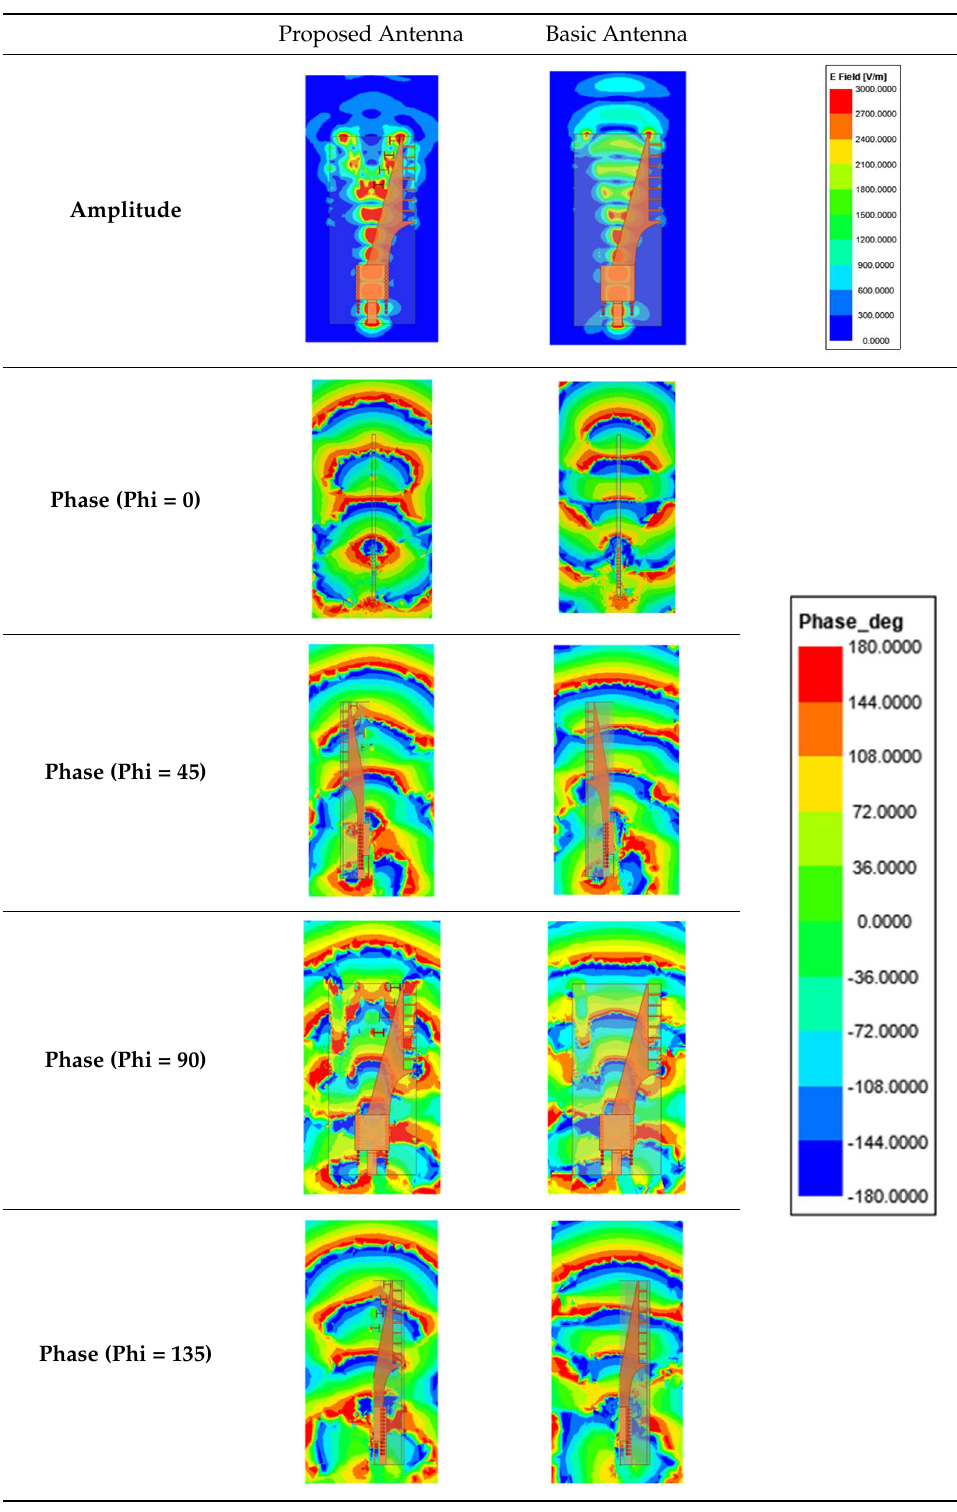
8 of 14 Figure 5. The performances of antennas with different numbers of subwavelength elements in each row. ( a ) |S 11 |. ( b ) The amplification of HPBW in all cut−planes. To qualitatively analyze the reason why HPBW was broadened, the E−field amplitude and phase results of the basic ALTSA and the proposed wide−beam antenna are given, as shown in Table 2. At the same time, considering that the performances in each cut−plane were relatively close, only the corresponding phase diagrams in the phi = 0°, 45°, 90°, and 135° cut-planes at 15 GHz are presented here. As can be seen from Table 2, before loading subwavelength units, the E−field energy distribution between the two tapers of basic ALTSAs was relatively uniform, and the beam energy was mainly shot toward the boresight. However, after adding subwavelength units, the E−field energy distribution in this area significantly changed, and the energy was mainly concentrated near the subwavelength units, deviating from the boresight and transmitting to both sides. Similarly, the subwavelength elements change the equivalent dielectric constant of the